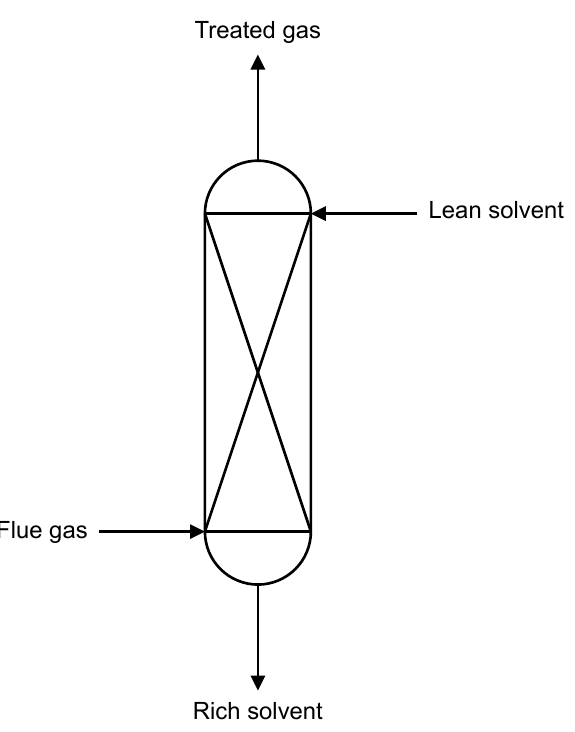
Figure 1. A schematic diagram of a packed absorption